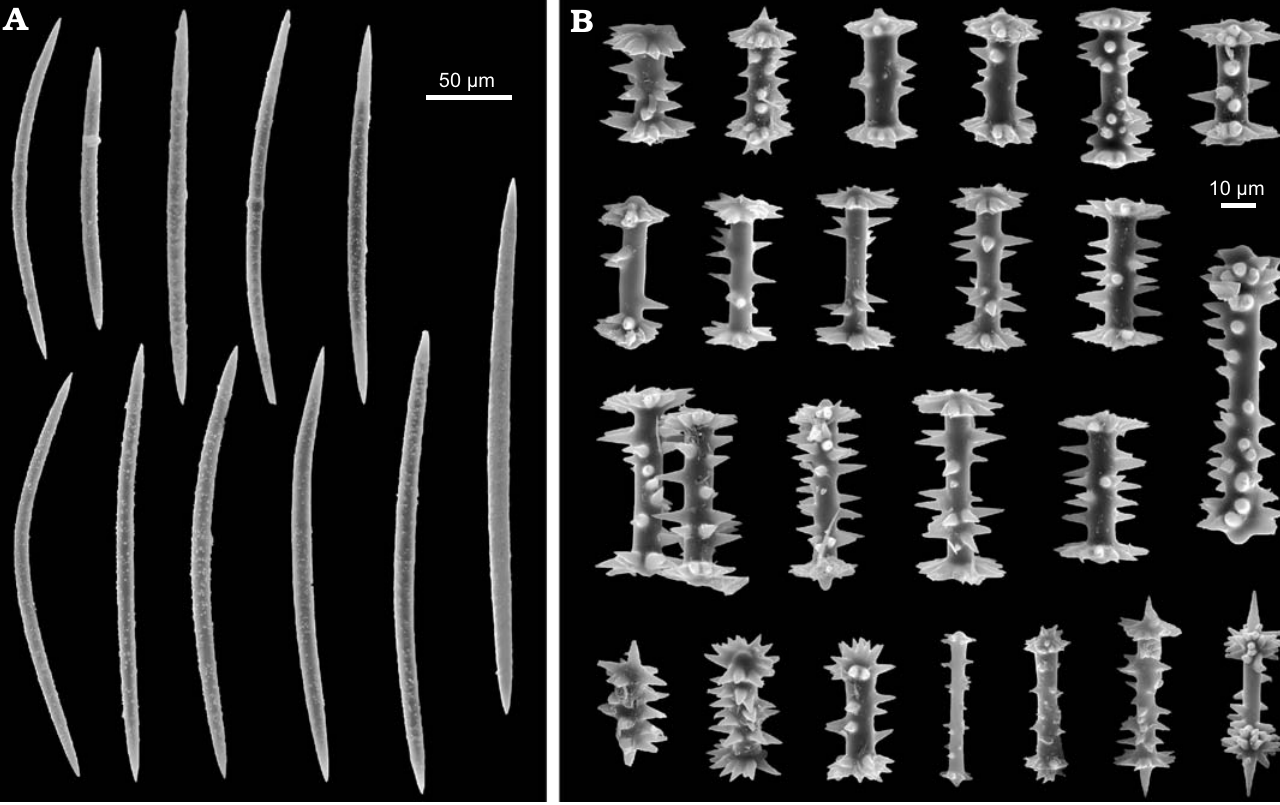
Fig. 18. Ephydatia cf. facunda Weltner, 1895, Spongillida: Spongillidae, ZPAL Pf23; Lutetian, middle Eocene , Giraffe Kimberlite maar, Northern Canada. A . Oxeas (megascleres). B . Birotules (gemmuloscleres). SEM images. Modified from Pisera et al.